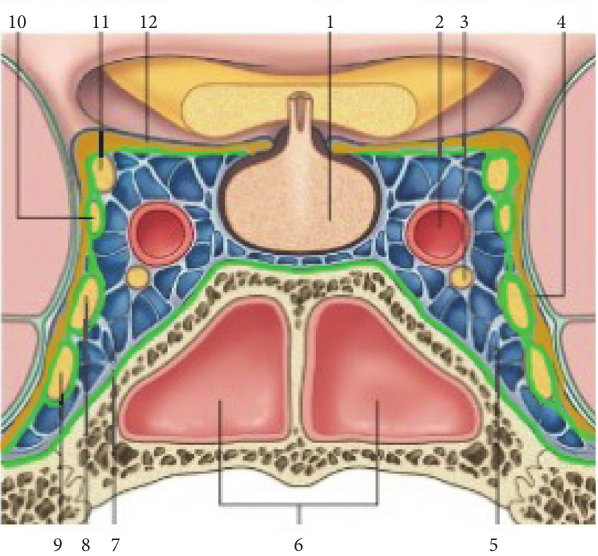
Figure 4: Anatomical diagram of the cavernous sinus: 1: hypophysis, 2: internal carotid artery, 3: 6th CN, 4: meningeal (outer) layer, 5: cavernous sinus, 6: sphenoid sinus, 7: endosteal (inner) layer, 8: V 1 , 9: V 2 , 10: 4th CN, 11: 3rd CN, and 12: the outer layer at the diaphragma sellae. The endosteal layer is marked in green, while the meningeal layer is marked in